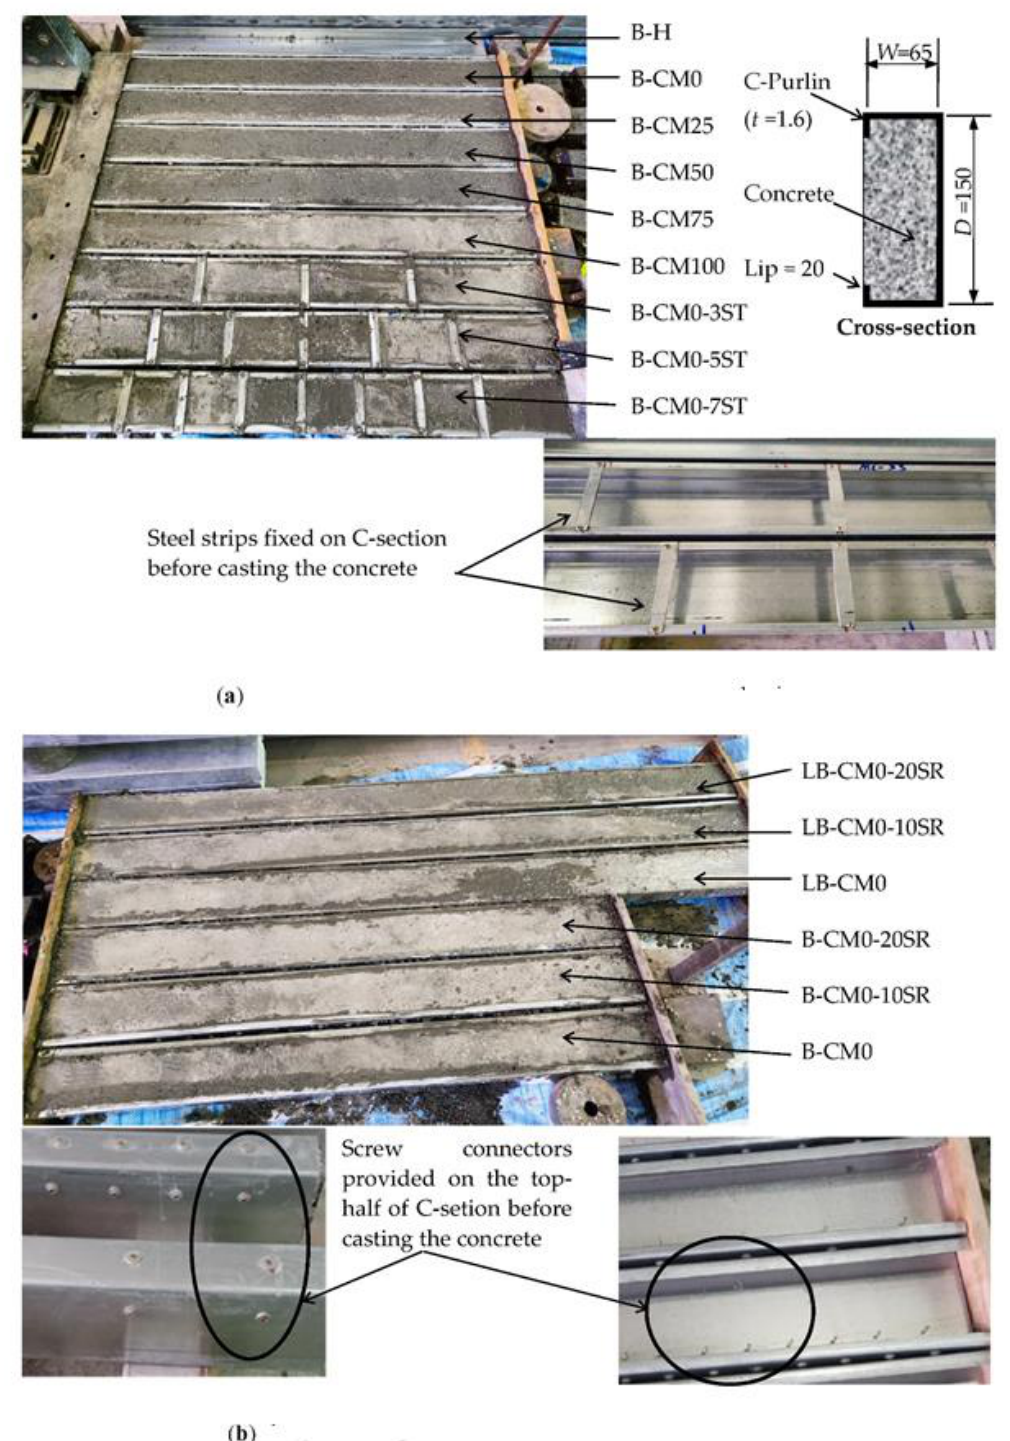
Figure 2. Specimens of C-sections filled with concrete: ( a ) concrete filled C-section specimens with/without steel strips; ( b ) short and long specimens stiffened with screw connections.